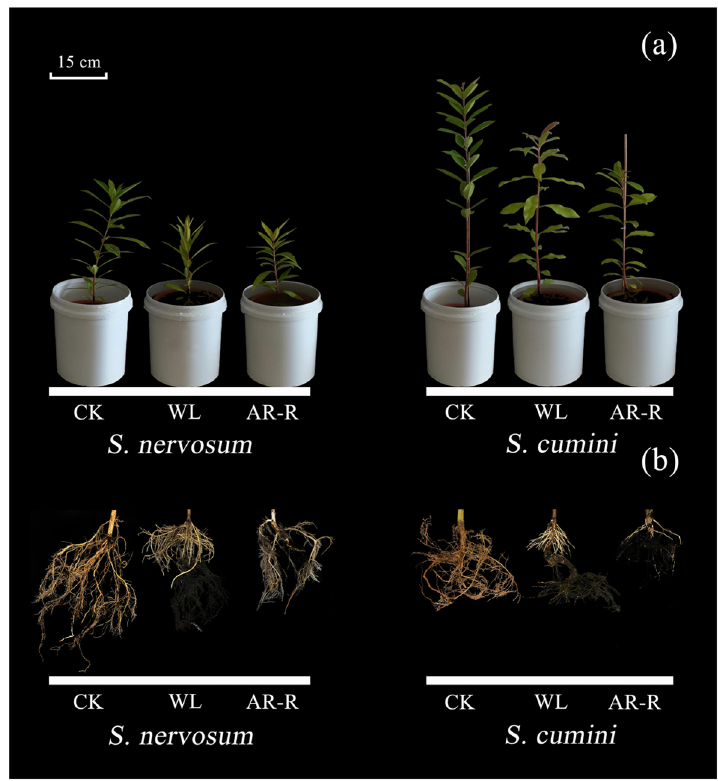
Fig. 1 Aboveground ( a ) and belowground ( b ) growth response of S . nervosum and S . cumini saplings to waterlogging with or without adventitious root removal. Treatment: CK, well-watered; WL, waterlogging; AR-R, adventitious root